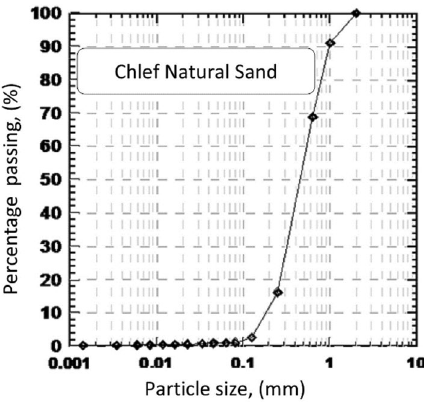
Fig. 1 General view of the triaxial apparatus [19]